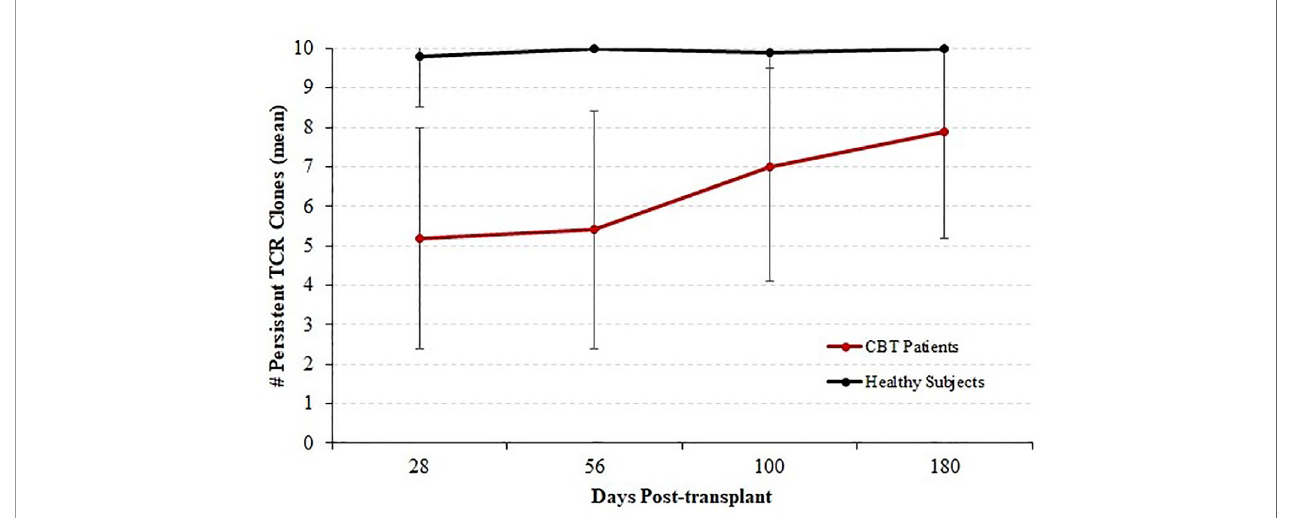
FIGURE 3 | Persistence of T cell receptor (TCR) clones during immune reconstitution. Starting with each patient who survived through day 365 and for whom samples were available for sequencing at each time-point (N = 14), each of the top 10 TCR clones by frequency was classi fi ed as either persistent (observed again in the same patient at any later time point) or transient (not observed again at any level in subsequent samples from the same patient). We report the mean and standard deviation of the number of persistent TCRB clones among patients. The number of persistent clones was highly variable, ranging from 1 to 10, but the mean number of persistent clones increased with time indicating a stabilizing TCRB repertoire by 1-year posttransplant. Four healthy subjects were analyzed in the same fashion over a similar time-course; and the number of persistent TCR clones ranged from 9 to 10 with a median of 10.